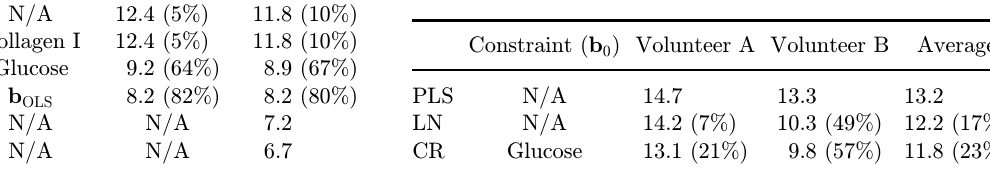
Table 4. Comparison of di®erent calibration methods with the volunteer data. Column 1 indicates the constraint used, columns 2 to 4 list the SEV values obtained from 2 represen- tative volunteers and the average over all volunteers, with corresponding error reduction compared to PLS in parentheses. See text for